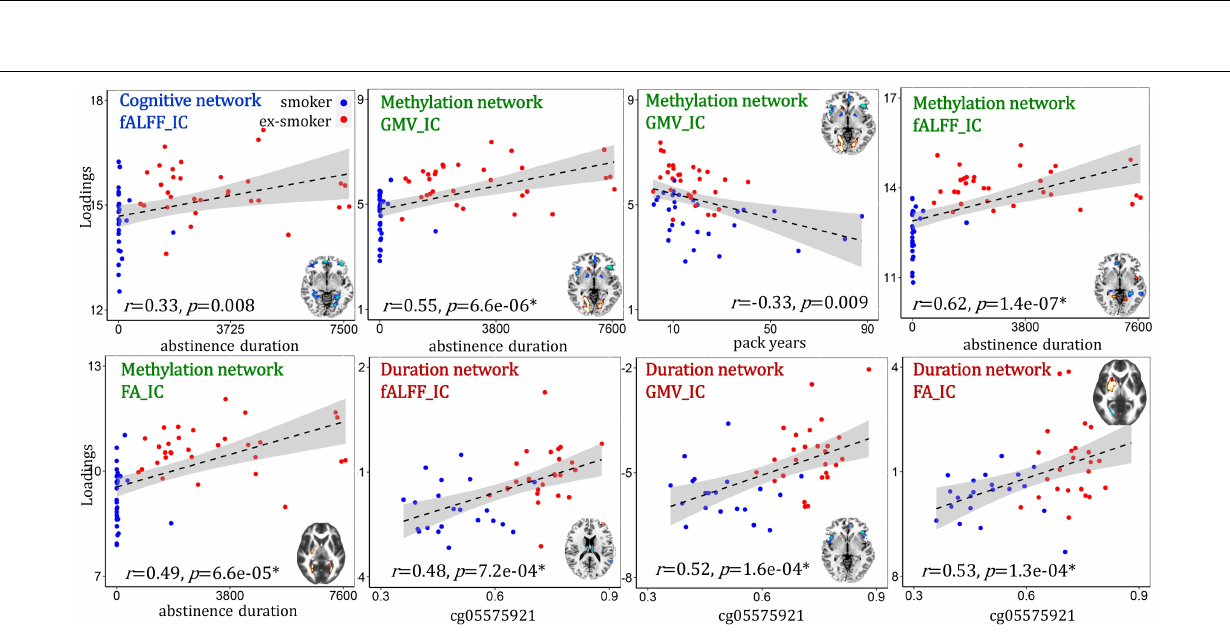
FIGURE 5 | Correlations between the identified multimodal brain networks and smoking-related